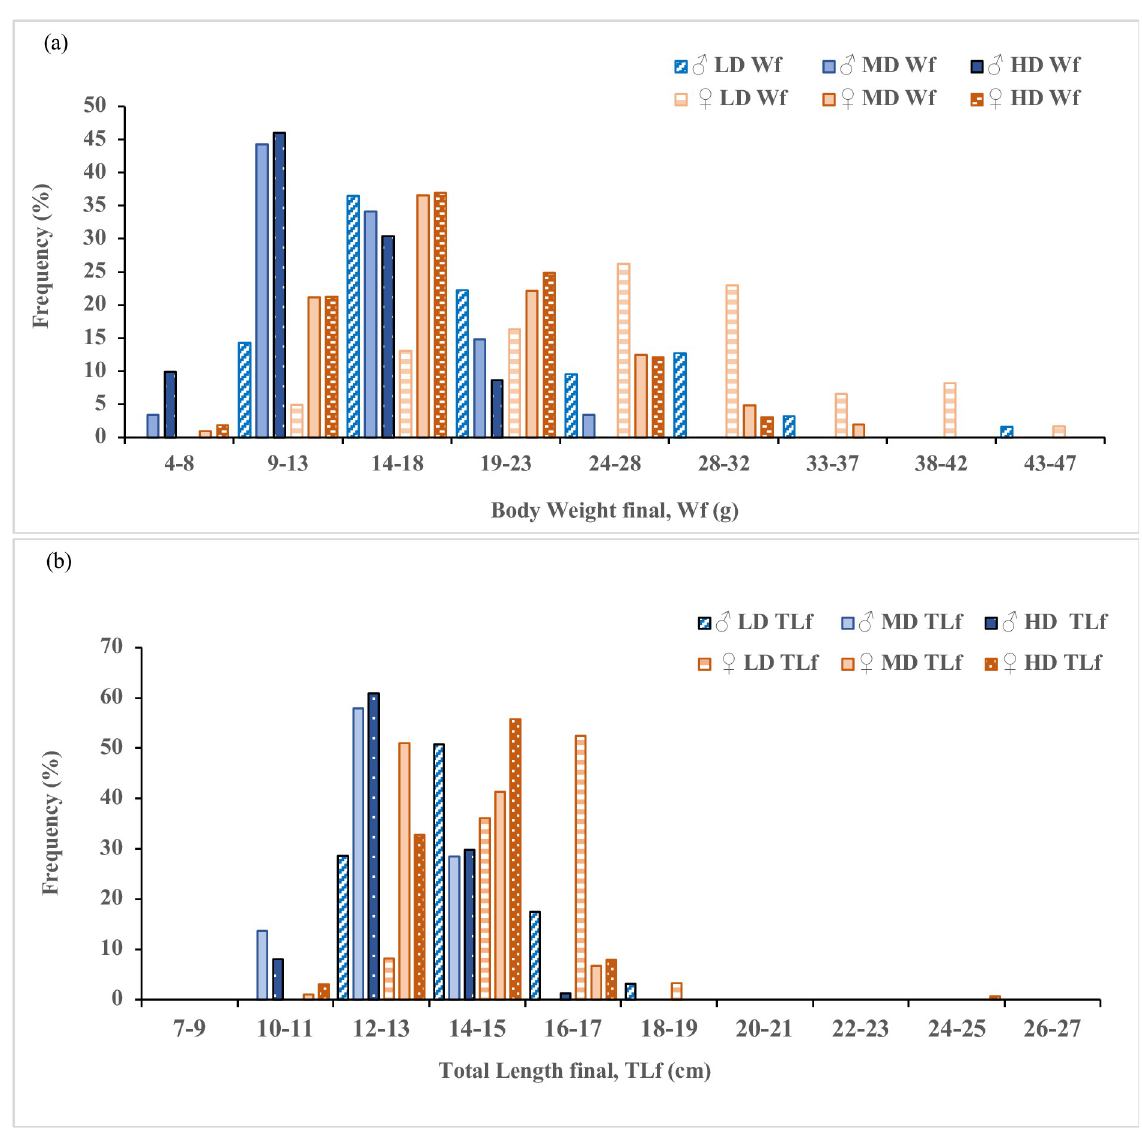
Fig 2. (a) Body weight (g) and total length (cm) frequency (%) distribution of male and female Perca flavescens reared at different stocking densities, (b) final Total length (cm) frequency (%) distribution of male and female Perca flavescens reared at different stocking